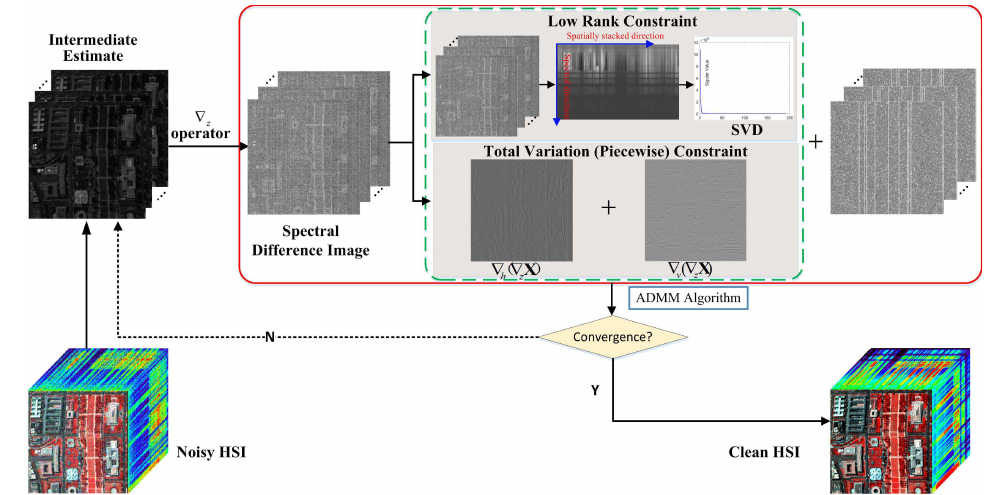
Figure 1. Flowchart of the proposed